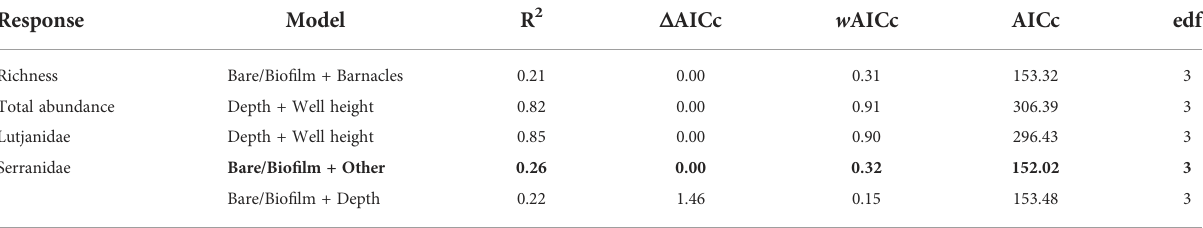
TABLE 4 Generalised additive mixed models (GAMs) for predicting fi shery target species richness, total fi shery target species abundance (sum of MaxNs for all species), and the total abundance of Lutjanidae and Serranidae families observed on subsea wells in <150 m in the north-west, within 2 Akaike information criterion of the top